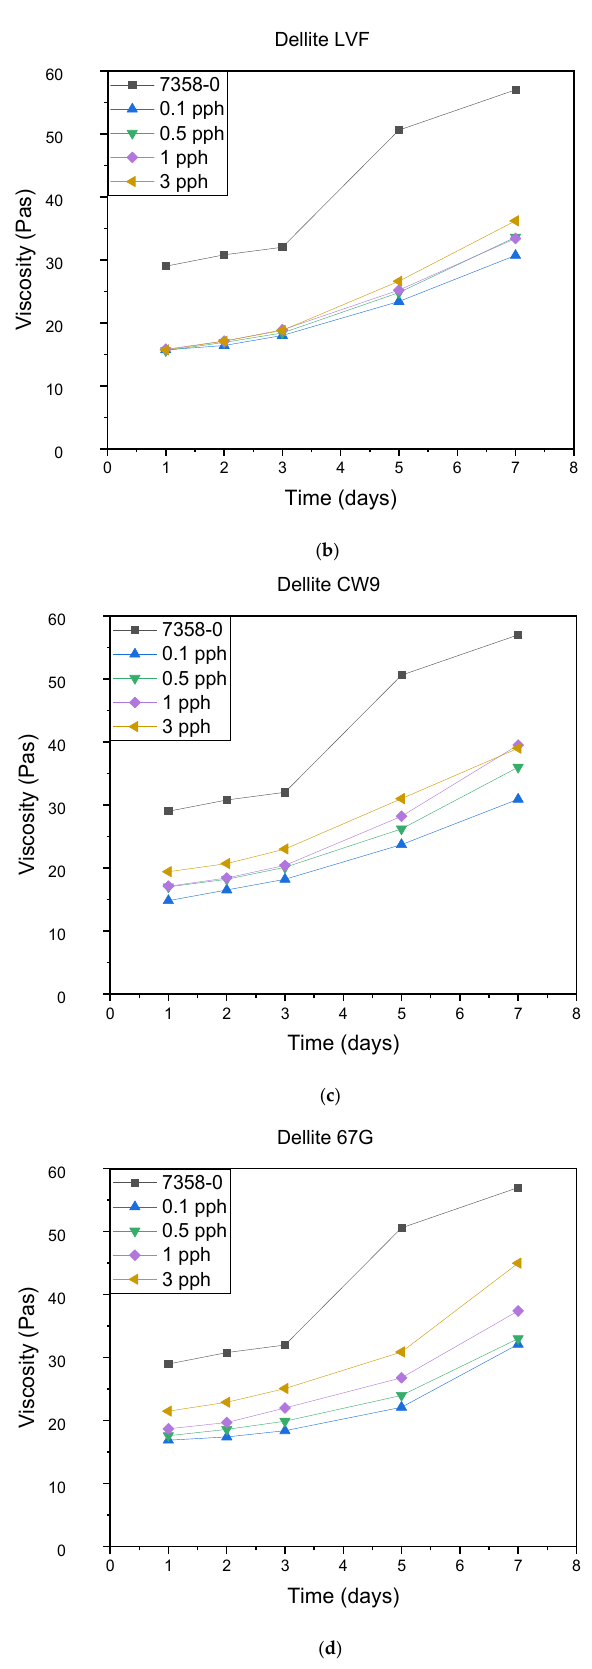
Figure 8. Pot life of pressure ‐ sensitive adhesives: marked with 0—adhesive without modification. ( a ) Dellite HPS, ( b ) Dellite LVF, ( c ) Dellite CW9, and ( d ) Dellite 67G.